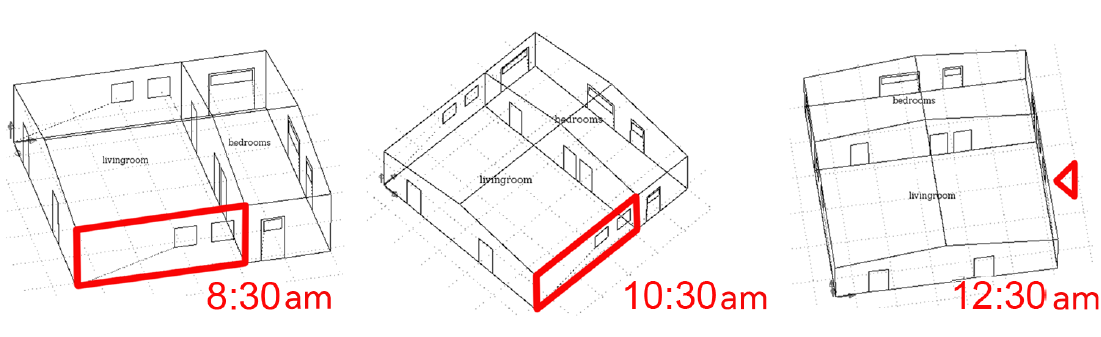
Figure 4. Building model in ESP-r: envelope geometry and orientation.